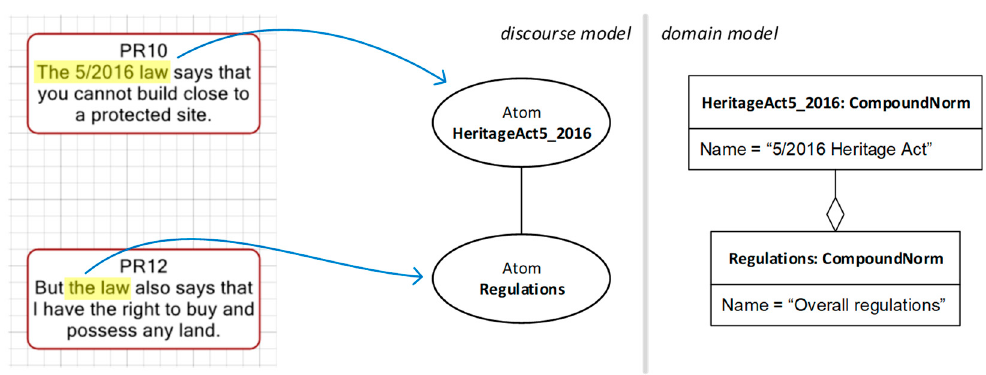
Figure 11. Discourse and domain models for the interpretation that “The 5/2016 law” and “the law” refer to different but related things.